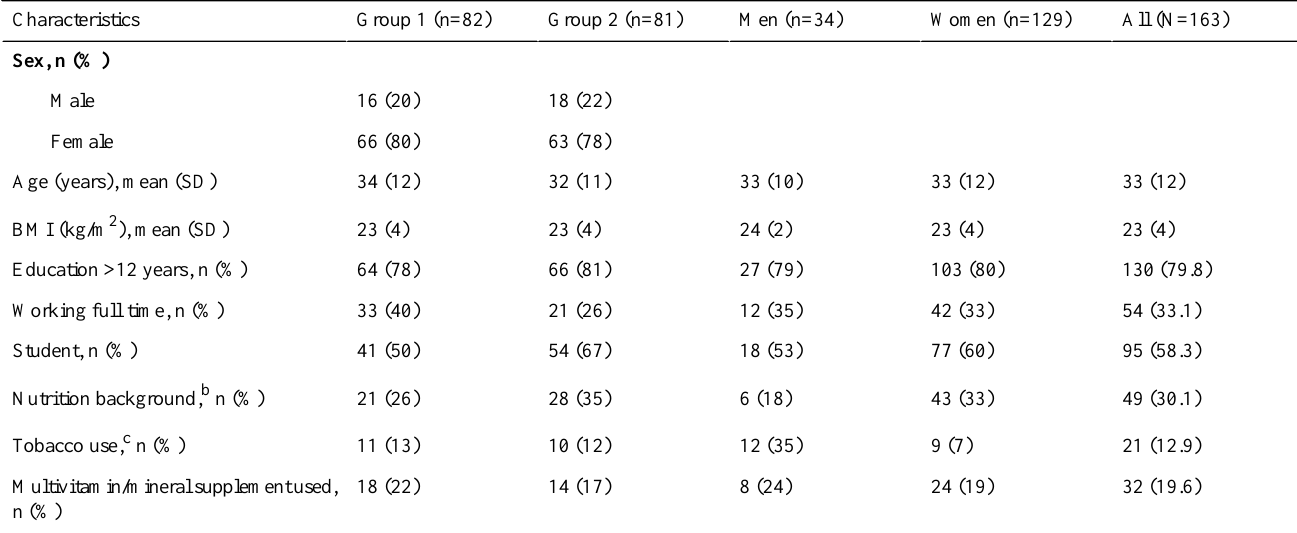
Table 1. Characteristics a of participants included in the validity analysis